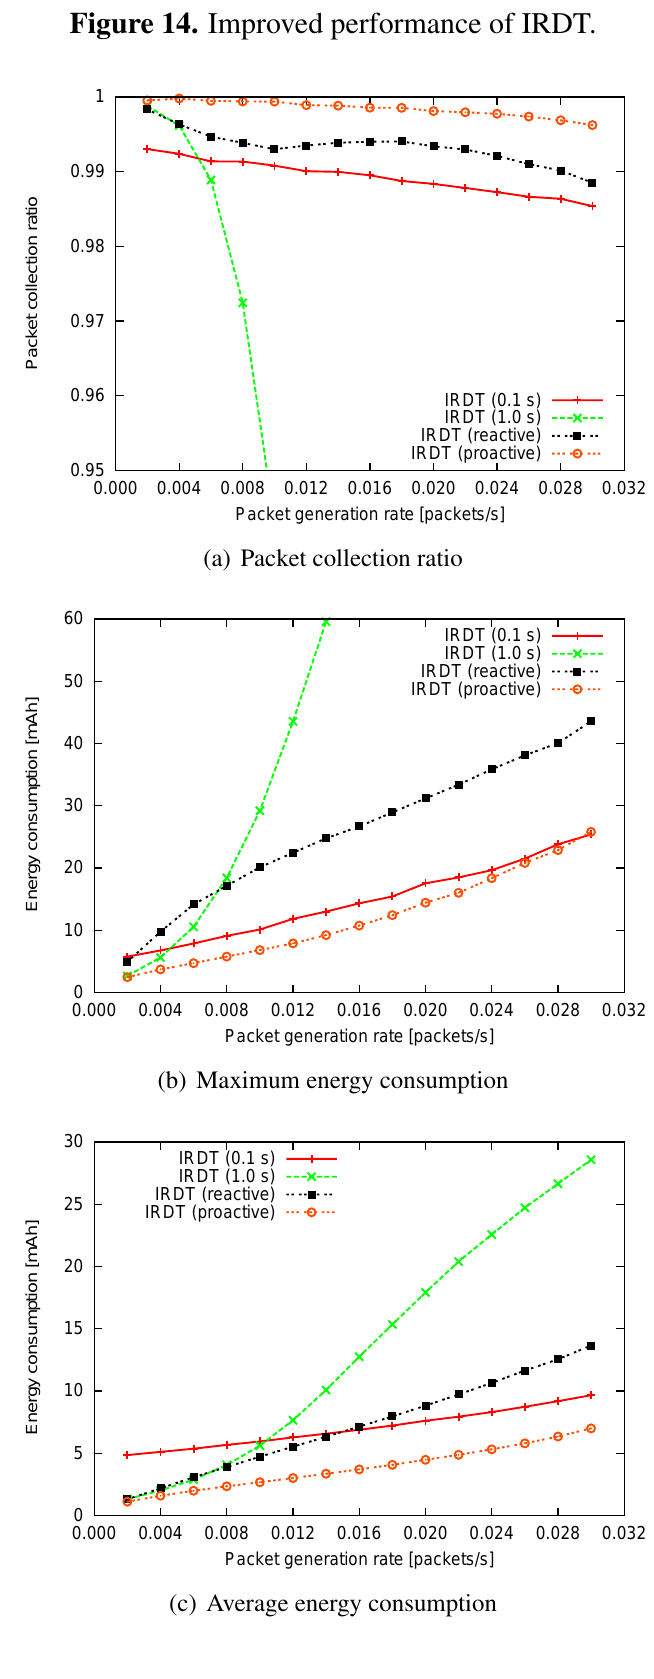
Figure 14. Improved performance of